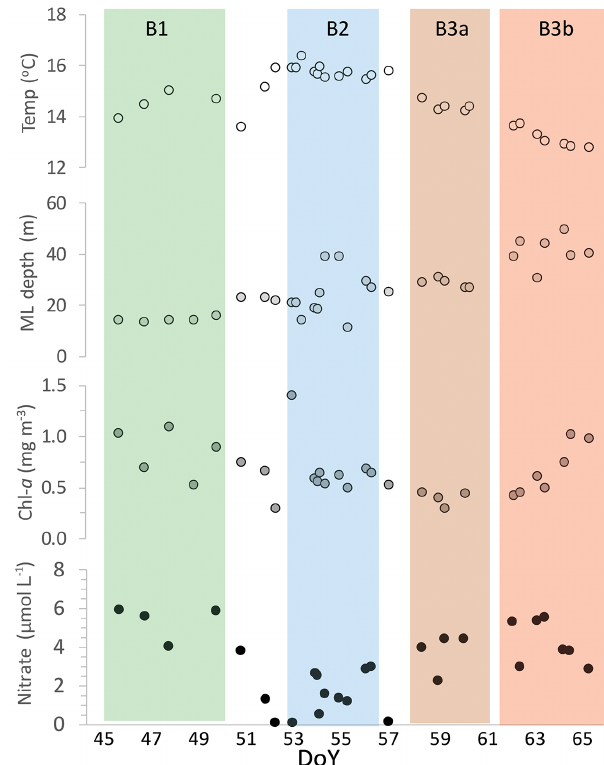
Figure 7. Surface water properties (2–10m) recorded at each sta- tion during the SOAP voyage: temperature (Temp, ◦ C), mixed layer depth (ML depth, m), chlorophyll a (Chl- a , mgm − 3 ) and nitrate concentration (µmolL − 1 ) plotted against day of year (DoY), with the occupation period for each bloom indicated by the vertical shaded bars and bloom labels at the top of the